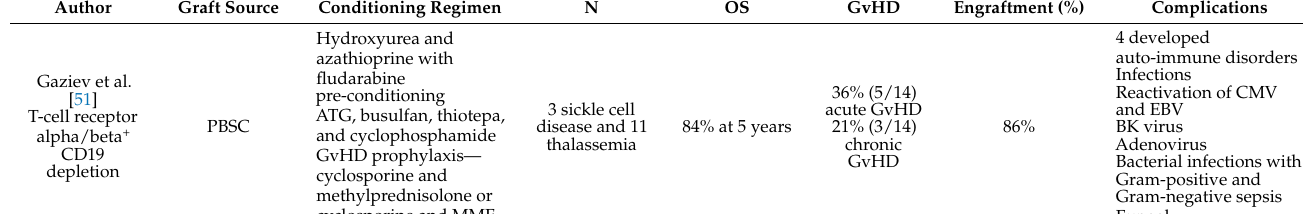
Table 3. Transplant outcomes from published studies using TCD and TCR platforms for haplo-HSCT for